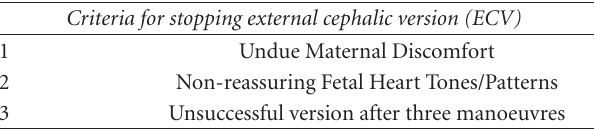
Table 4: Grimsby ECV rule of three ±